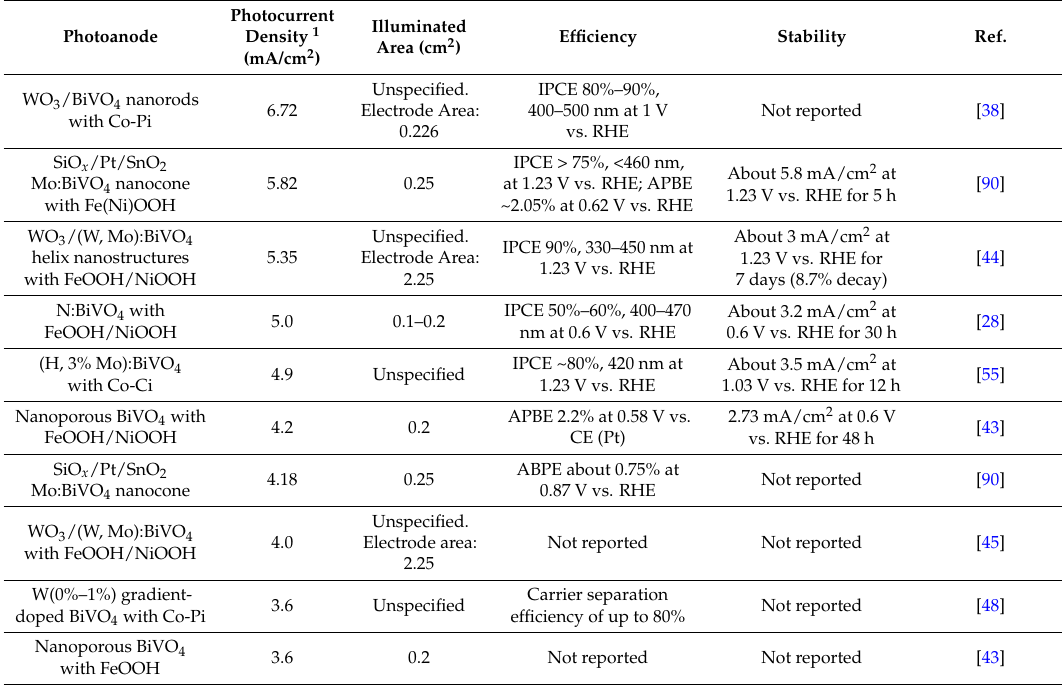
Table 1. BiVO 4 ‐ based photoanodes with the highest photocurrent density to date. Table 1. BiVO 4 -based photoanodes with the highest photocurrent density to date. Photoanode